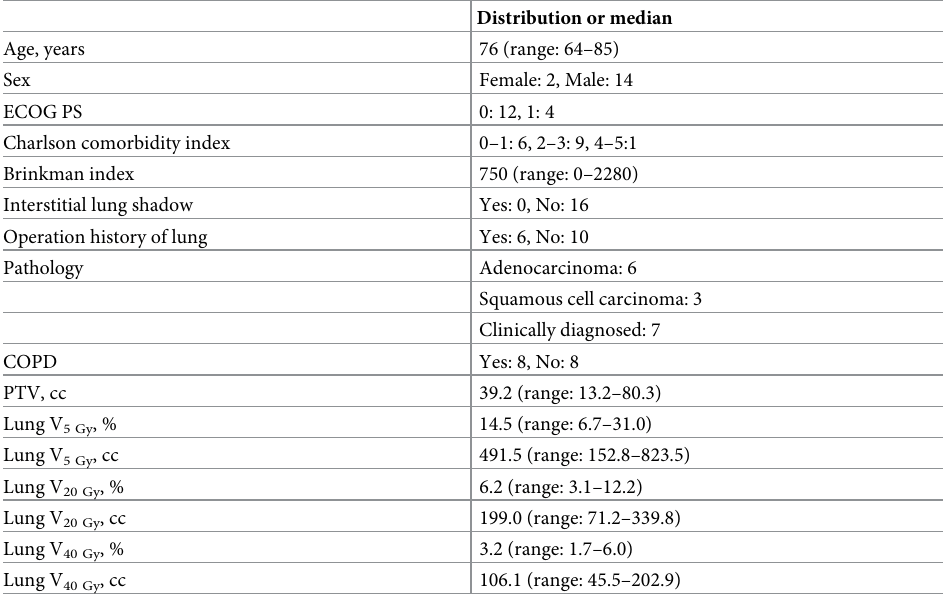
Table 1. Patient characteristics.